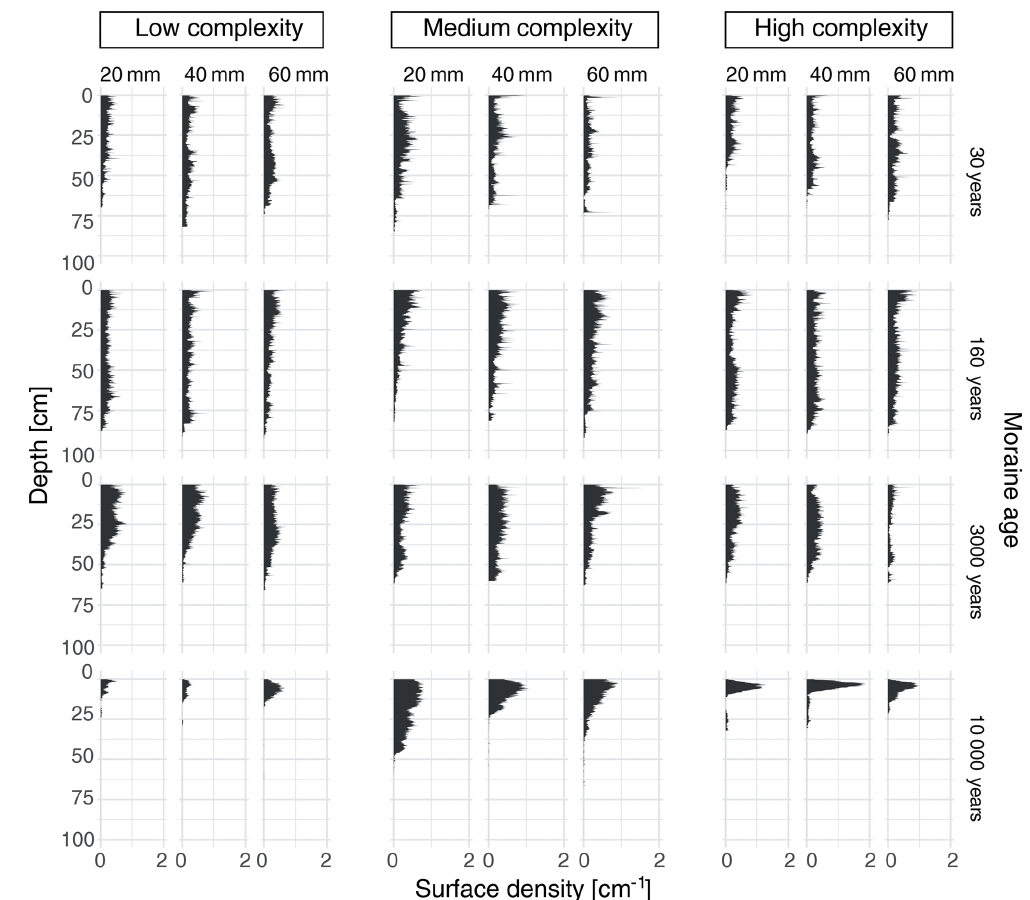
Figure 8. Surface area density profiles per age class, vegetation complexity, and irrigation amount (20, 40, and 60mm). A high surface area density indicates a large number of small